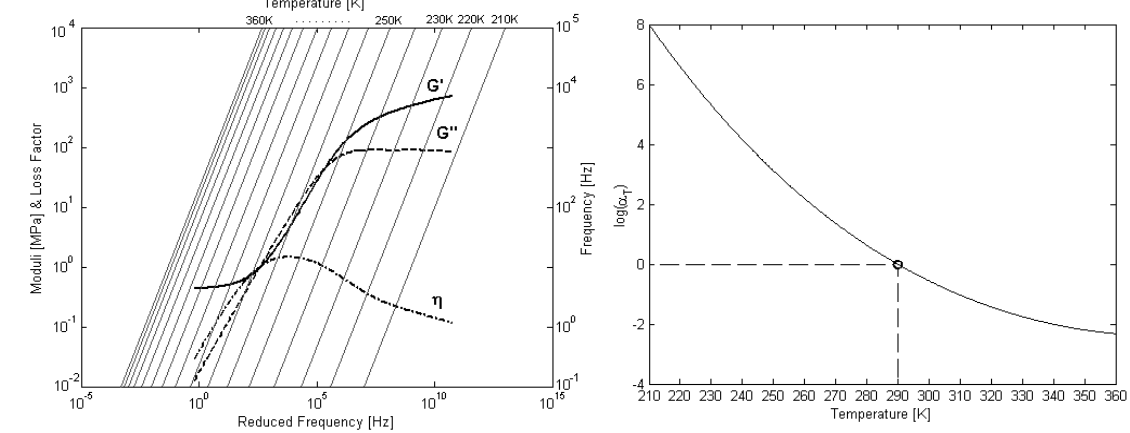
Fig. 3. Master and shift factor curves for the 3M TM ISD112 viscoelastic